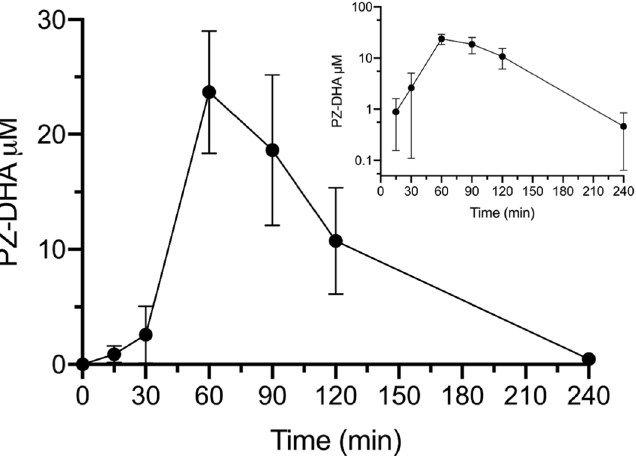
Figure 4. Intraperitoneal administration of PZ-DHA results in absorption into the systemic circulation of Balb/c female mice. PZ-DHA (100 mg/kg) was administered by intraperitoneal injection to Balb/c female mice. Blood collection was performed and serum was separated. PZ-DHA was identified and quantified using a calibration curve (R 2 = 0.99) generated using a standard series of PZ-DHA concentrations made in mouse serum. PZ-DHA concentration was plotted against time. The elimination rate of PZ-DHA was determined using a semi-log curve of PZ-DHA concentration vs. time curve.